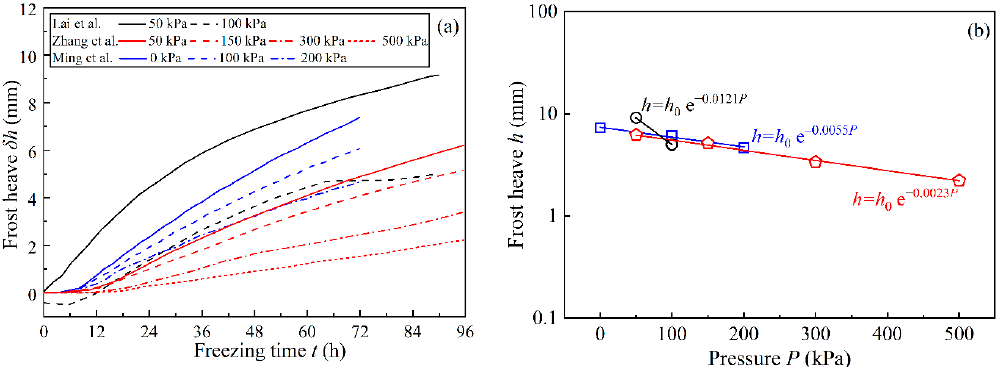
Figure 11. ( a ) Variation of frost heave under external load with the freezing time, ( b ) variation of final frost heave with the external pressure.